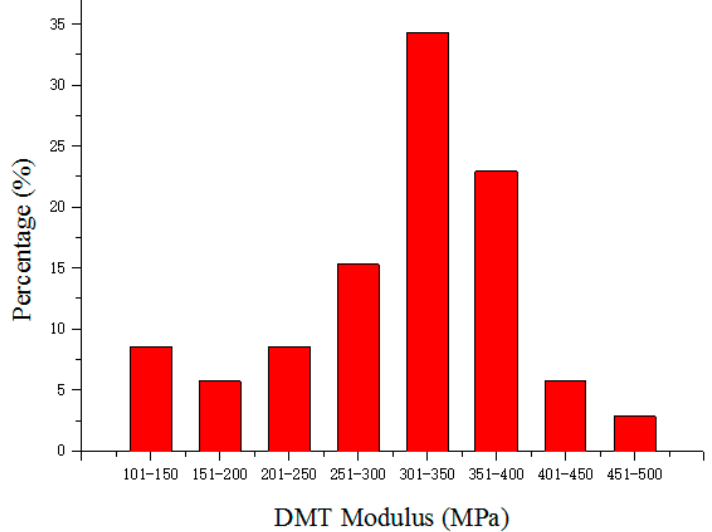
Figure 4. Distribution of the Young’s modulus of GP-GED-TA particles in Derjaguin-Müller-Toporov (DMT) modulus channels.